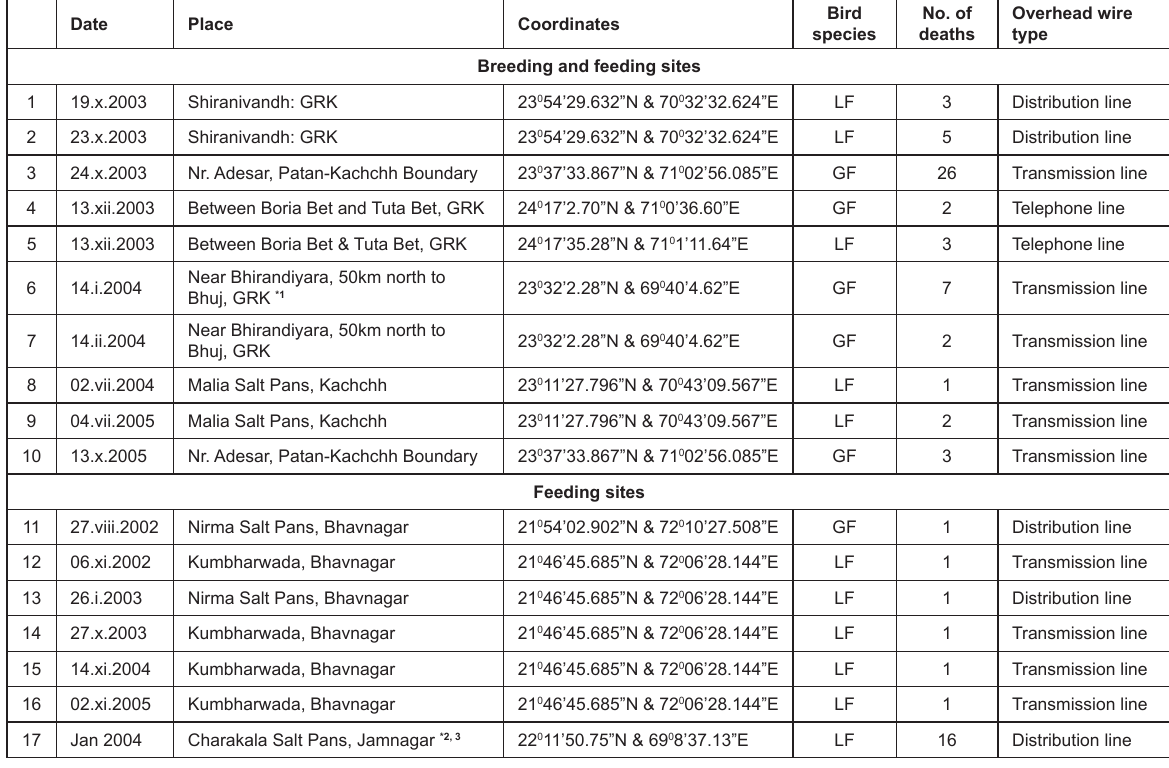
Table 1. Collision of flamingos with power and telephone lines in